Question: Briefly state, in one sentence, what is plotted here.
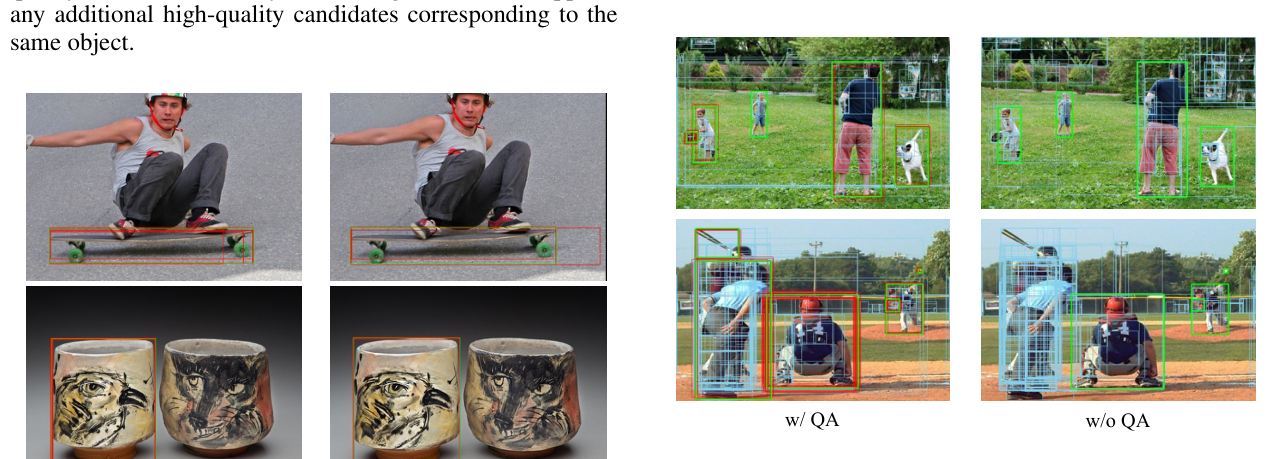
Answer: Visualization of all predicted boxes of queries in Deformable-DETR w/ and w/o QA. The green and red boxes are the predicted objects of merged queries and corresponding queries before merging, respectively. And the blue boxes are from queries with low predicted scores (< 0.5)